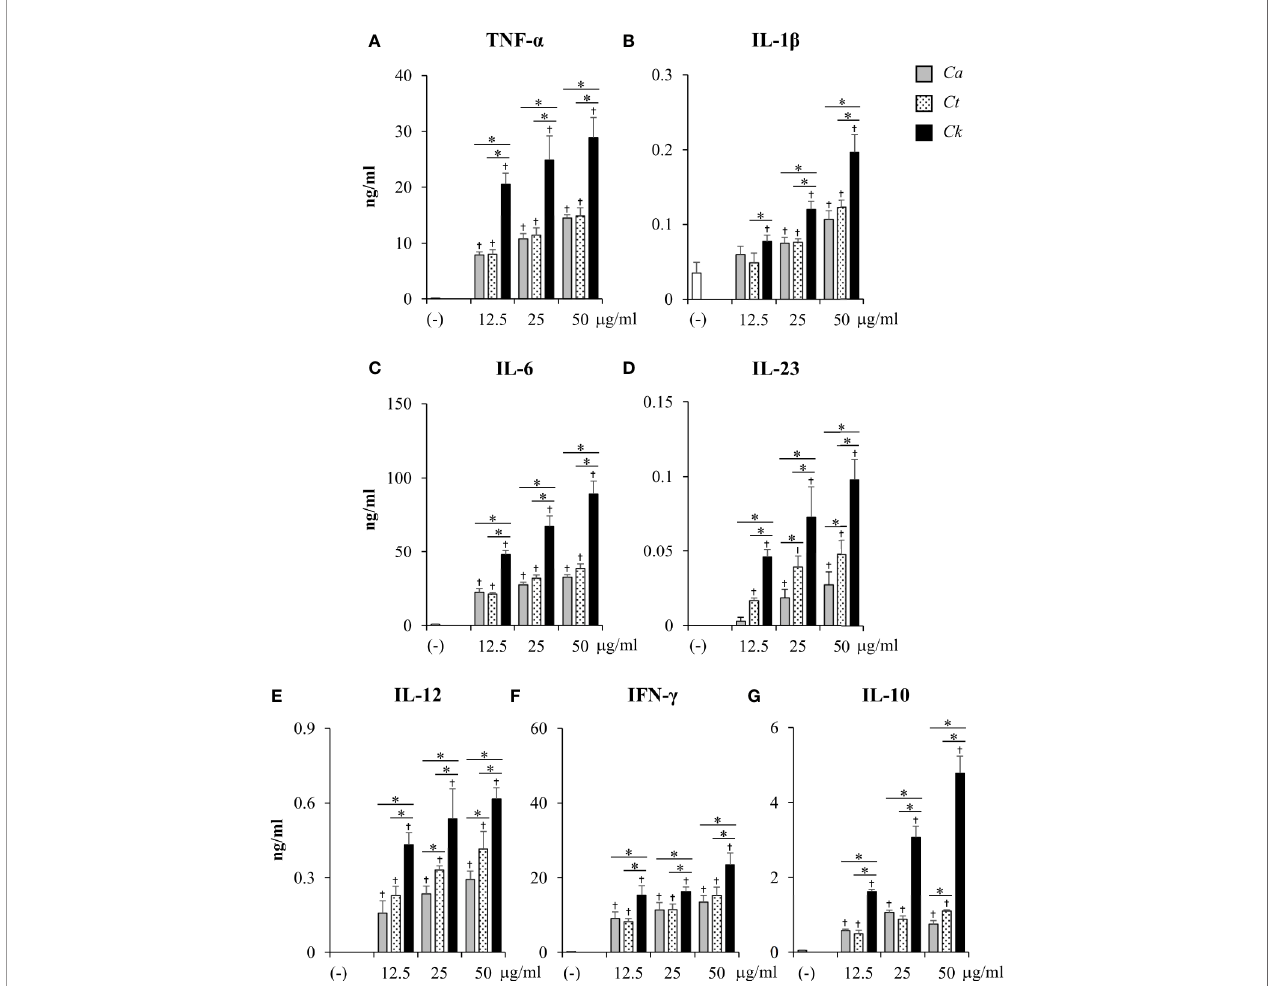
FIGURE 5 | Excessive pro-in fl ammatory and anti-in fl ammatory cytokine production in C. krusei b -glucan-stimulated bone-marrow derived dendritic cells (BMDCs). BMDCs were stimulated with 12.5, 25, and 50 µg/ml of b -glucans isolated from C. albicans , C. tropicalis , and C. krusei for 24 h. Subsequently, the culture supernatants were collected and levels of (A) TNF- a , (B) IL-1 b , (C) IL-6, (D) IL-23, (E) IL-12, (F) IFN- g , and (G) IL-10 were quantitated by ELISA. n = 5; data are representative of two independent experiments. † p < 0.05 compared with unstimulated BMDCs, * p < 0.05. (-), unstimulated BMDCs; Ca , C. albicans ; Ct , C. tropicalis ; Ck , C. krusei Figure S16 ). Among Candida b -glucans, C. krusei b -glucan was the most potent stimulus of cytokine production by DCs, especially production of the anti-in fl ammatory cytokine, IL-10.